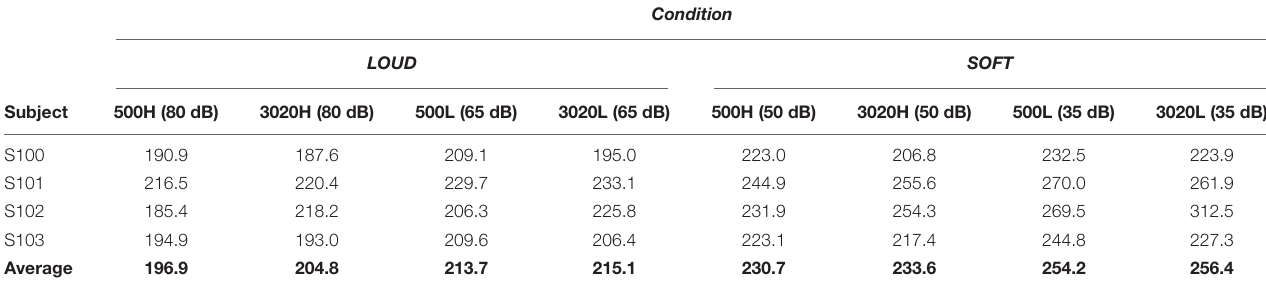
TABLE 2 | Mean RTs in ms for single targets in the two scenarios.